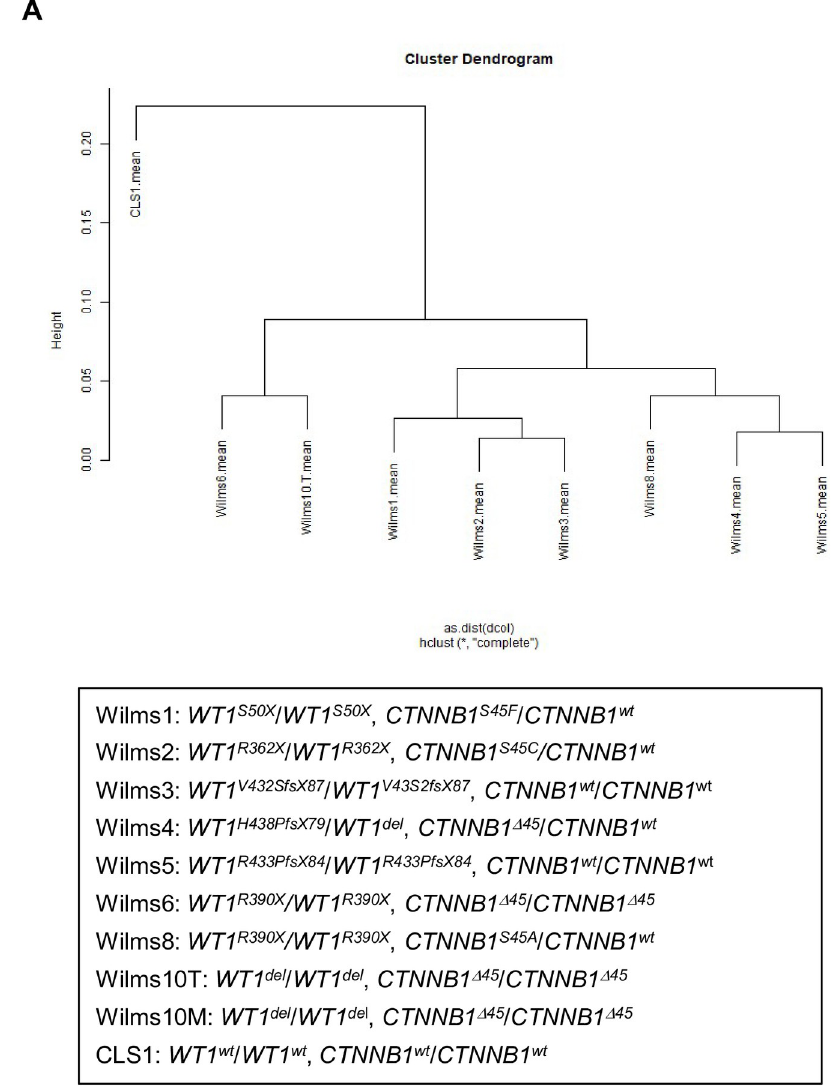
Fig 1. Cluster dendrogram of all WT1 mutant Wilms cell lines and a WT1 wild type cell line, CLS1, and their